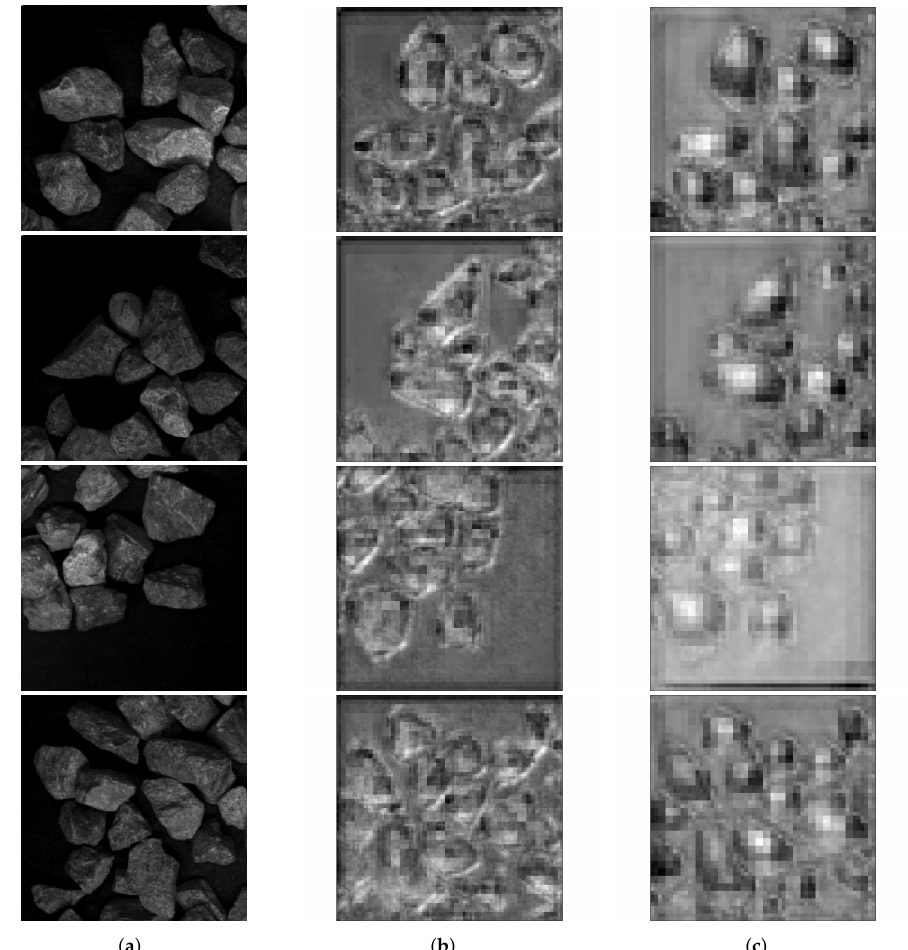
Figure 4. ( a ) Input images; ( b ) rhe feature maps from the original FPN; ( c ) the feature maps from the lightweight